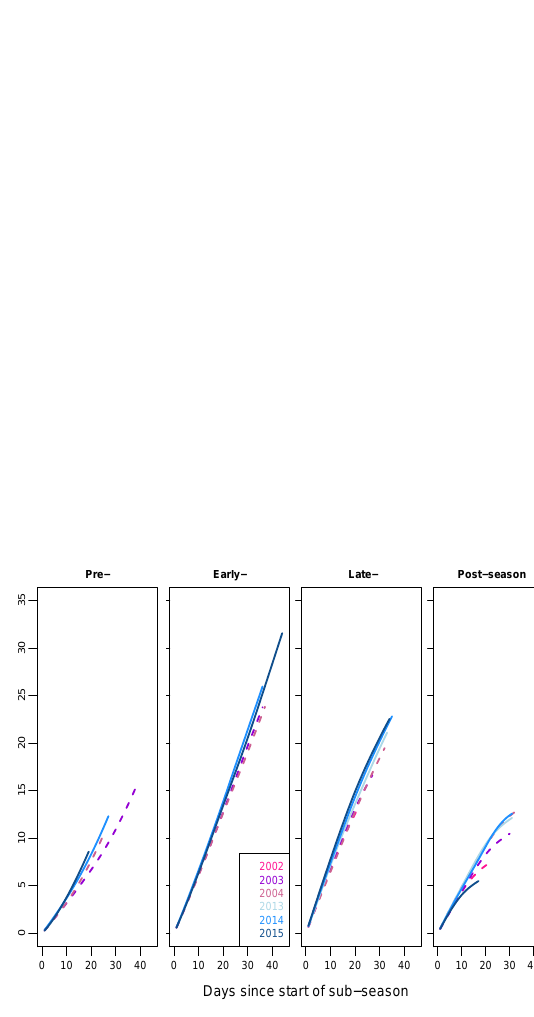
Figure B2. Sub-seasonal NDVI budgets for the control area for the historic (2002–2004) and recent (2013–2015) datasets. Time axes within this plotting scheme are identical to those used in Fig.